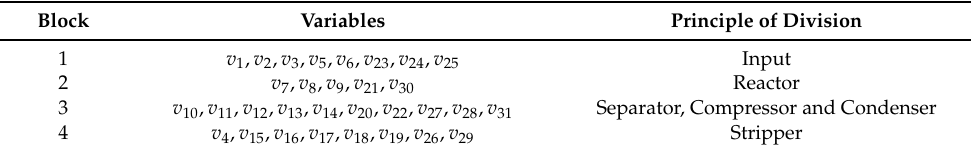
Table 2. The division of TE process variables.